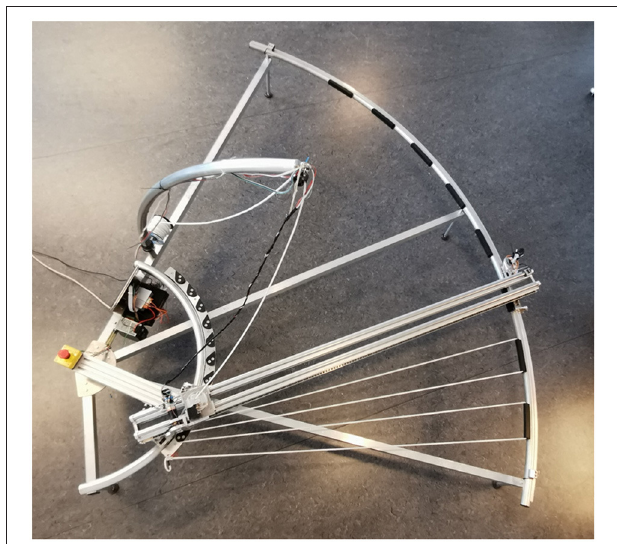
FIGURE 11 | Prototype of a 90 ◦ sector of a SPOKe module for testing of deployment and harvesting techniques.